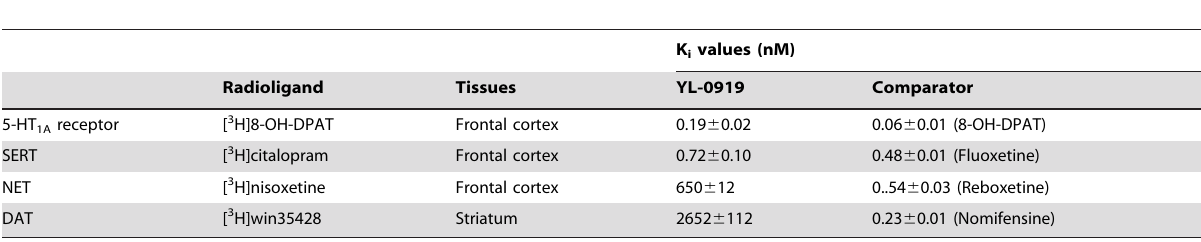
Table 3. The affinity of YL-0919 to 5-HT 1A receptor and monoamine transporters.